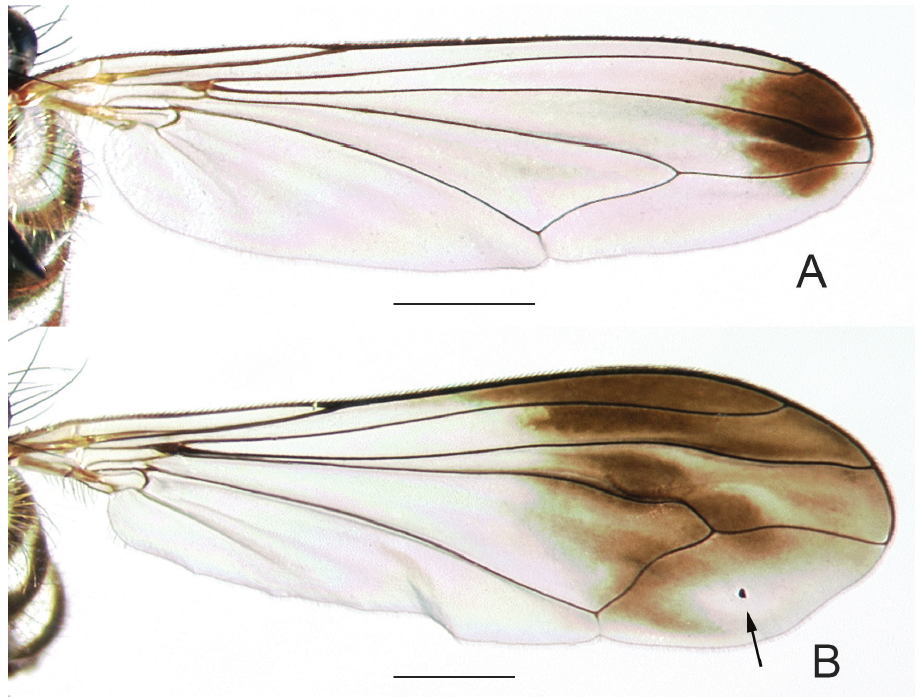
Figure 6. Wings of male A Liancalus querulus Osten Sacken, and B L. similis Aldrich. Scale bars = 1 mm. Note black speck in cell m of L. similis , indicated by arrow.